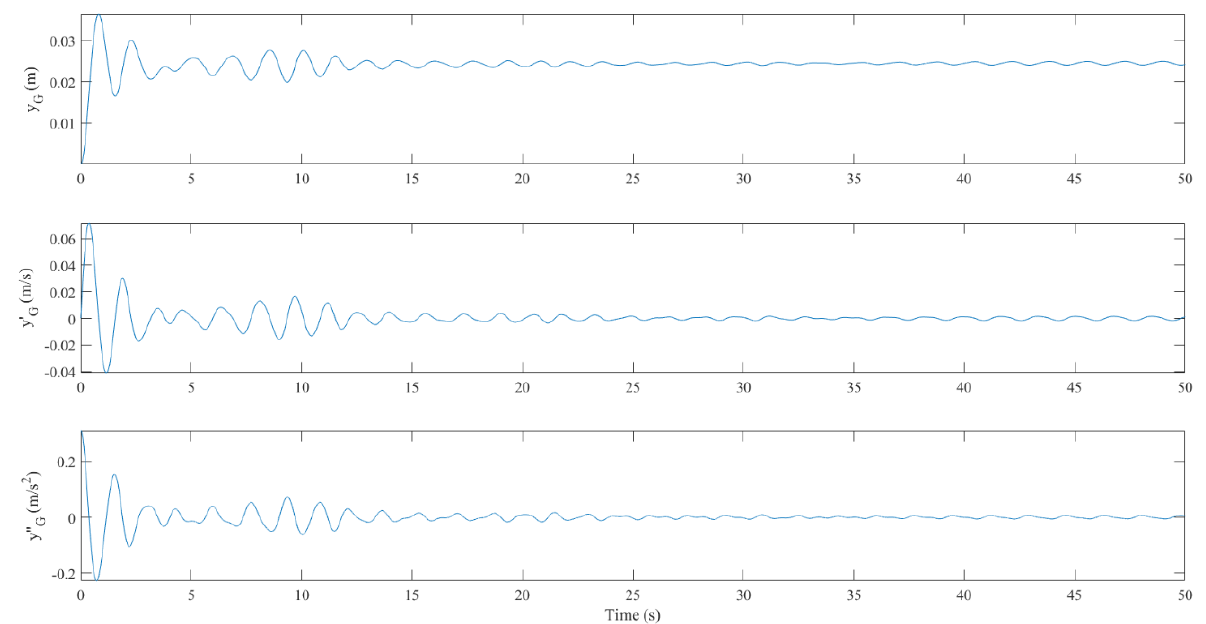
Figure 3. The horizontal displacement, velocity, and acceleration time histories of the floating body under free vibration at an initial 5° pitch.